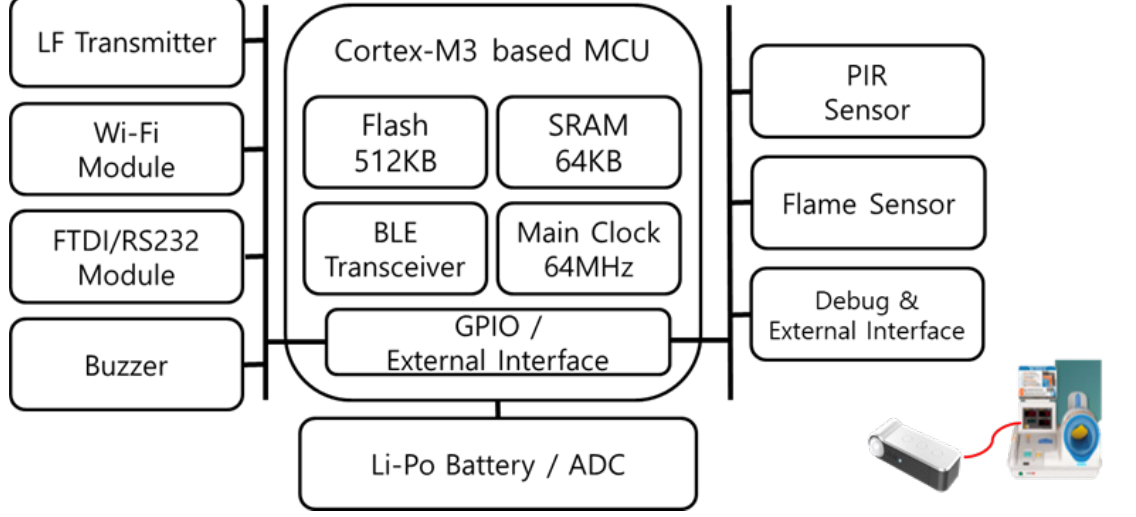
Figure 14. Hardware Block Diagram of Stationary Resource.